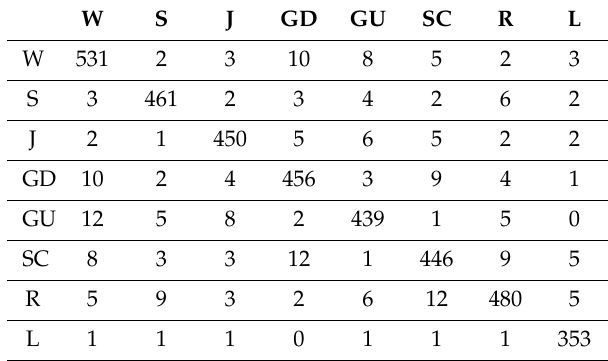
Table 6. Confusion matrix for HAR using 20 base classifiers based on KFDA